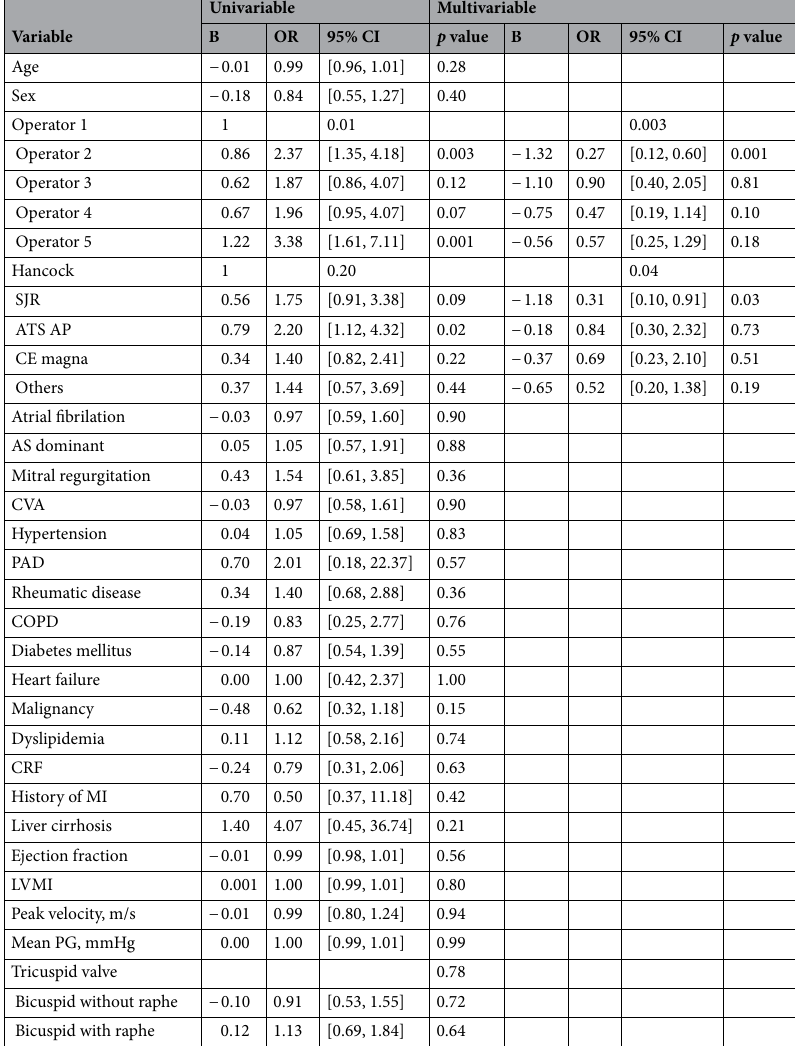
Table 5. Univariable and multivariable logistic regression analysis after propensity score matching to discriminate the patients with > 10% larger area-derived annulus diameter on CT (CT-Lg) compared to tissue annulus diameter of prosthetic valve from those ≤ 10% range of differences (CT-Sim). AS, aortic stenosis; BNP, brain natriuretic peptide; BUN, blood urea nitrogen; CE magna, Carpentier-Edwards PERIMOUNT Magna; CI, confidence interval; COPD, chronic obstructive pulmonary diseases; CRF, chronic renal failure; CVA, cerebrovascular accident; eGFR, estimated glomerular filtration rate; LVMI, left ventricular mass index; MI, myocardial infarction; PAD, peripheral arterial disease; PG, pressure gradient; SJR, St Jude Medical